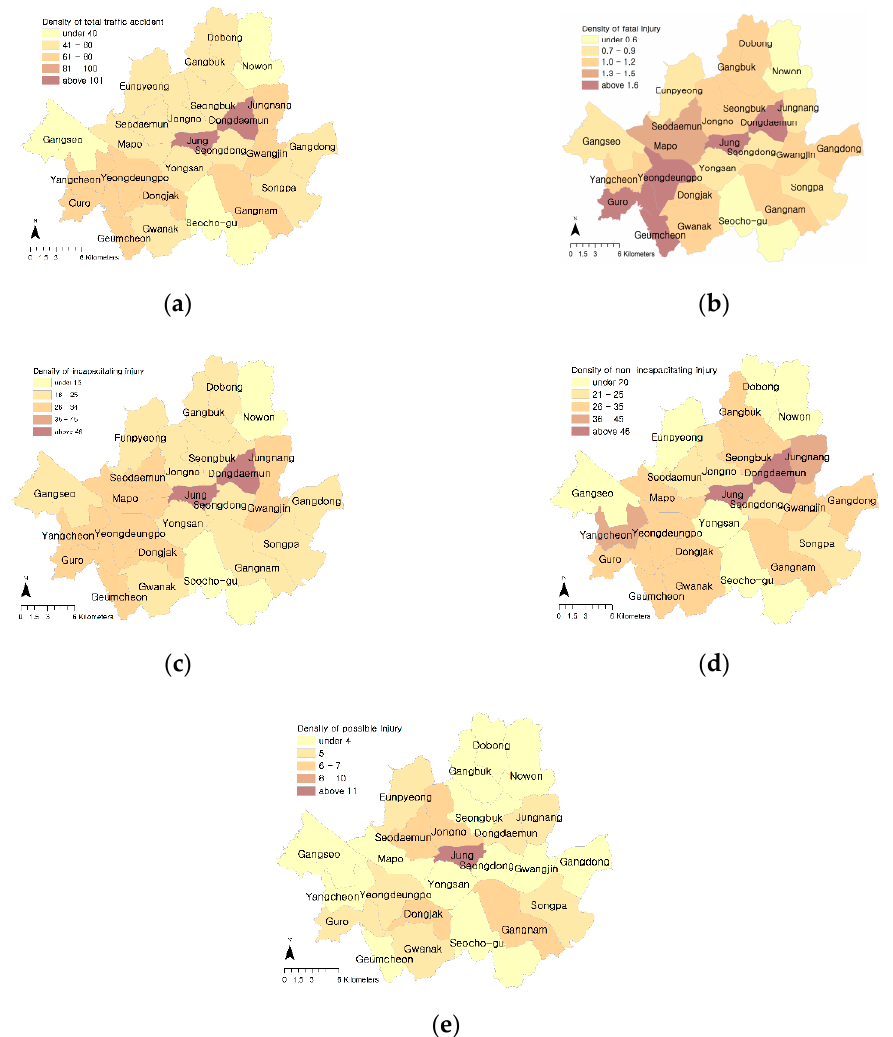
Figure 1. Spatial distribution of pedestrian injury severity: ( a ) Density of total pedestrian injuries; ( b ) Density of fatal injuries; ( c ) Density of incapacitating injuries; ( d ) Density of non-incapacitating injuries; and ( e ) Density of possible injuries.